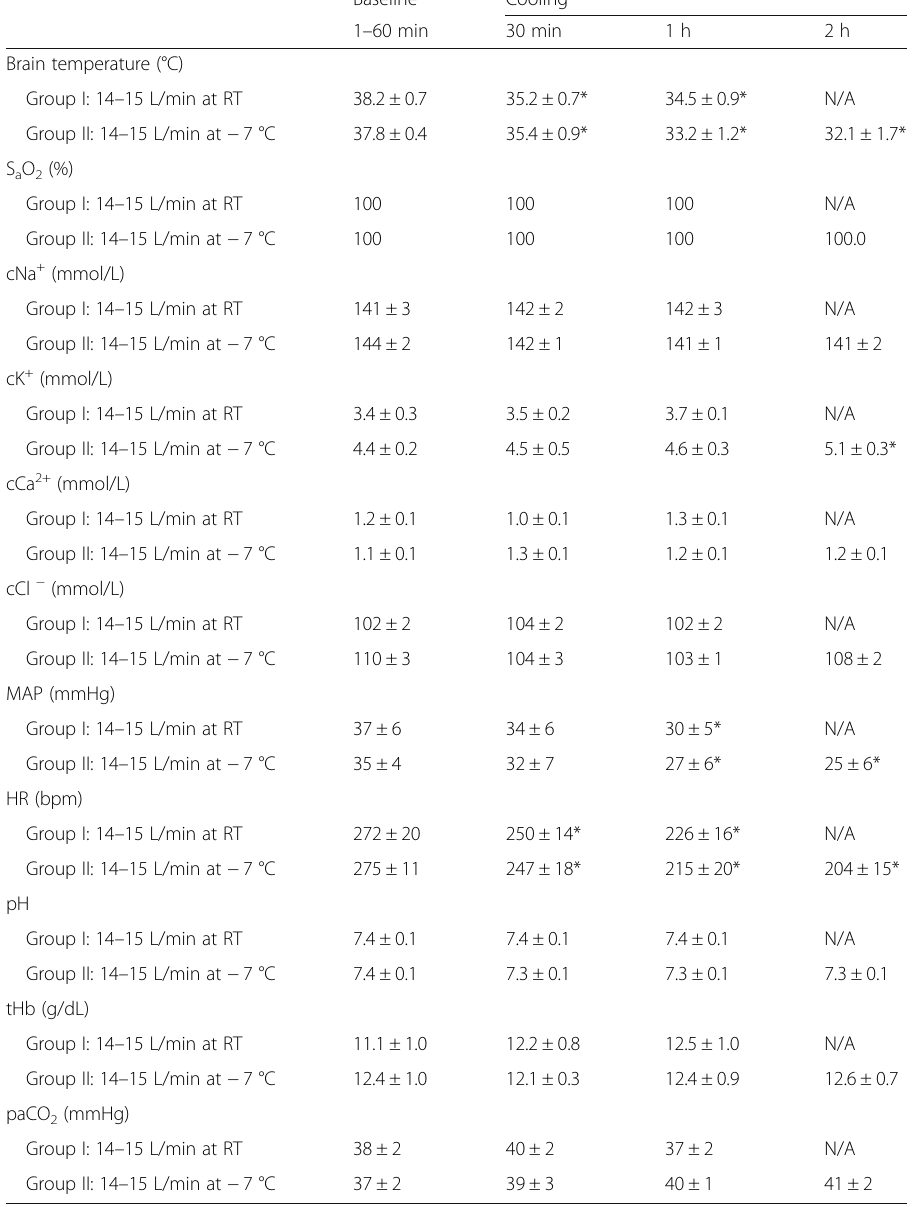
Table 1 Physiological parameters measured at different times during SBC within groups in rabbits Baseline Cooling 1 – 60 min 30